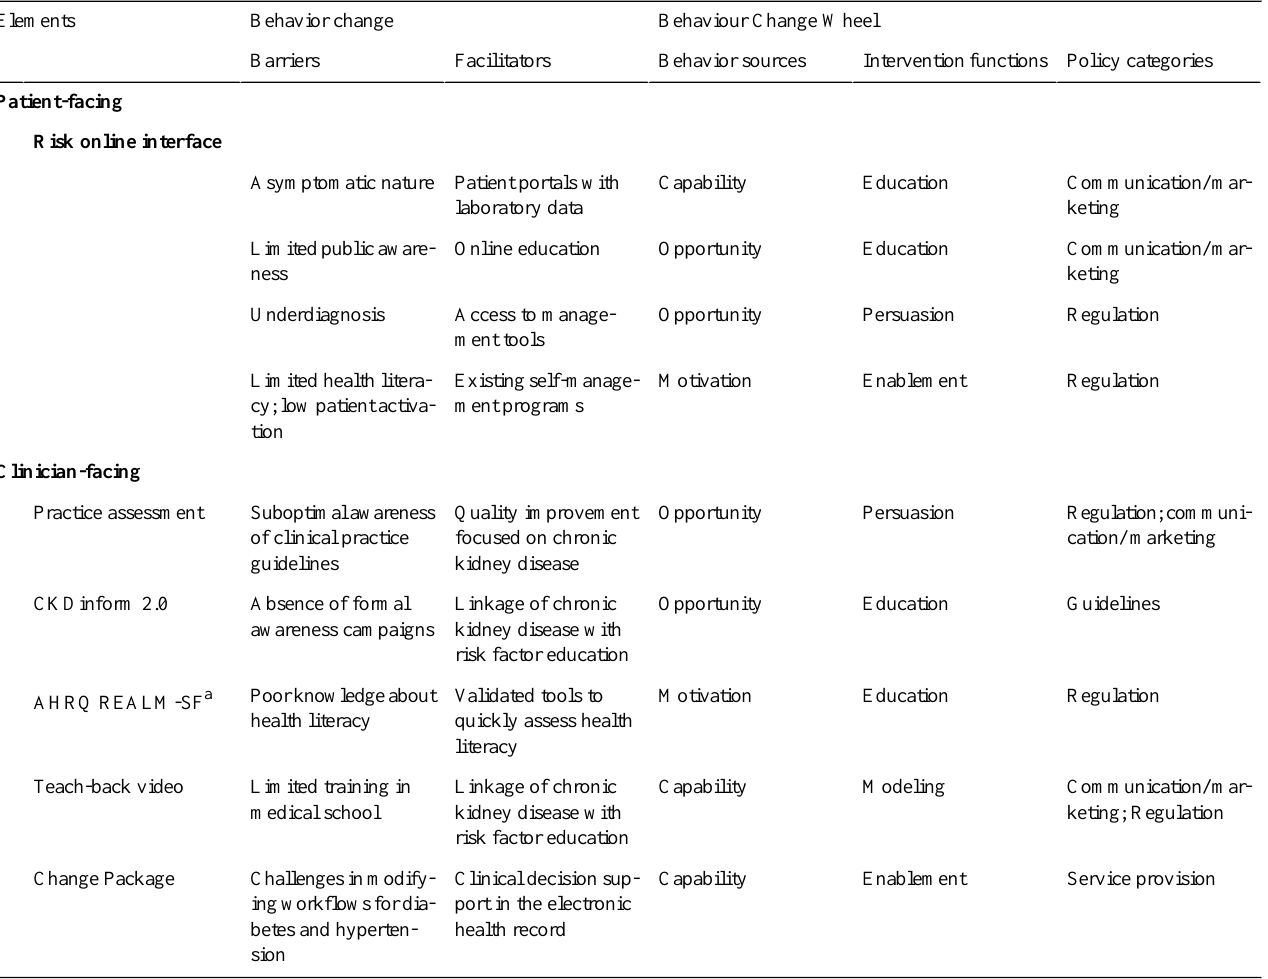
Table 1. Elements of the Kidney Score Platform informed by the 3 layers of the Behavior Change Wheel framework to directly address patient and clinician barriers and facilitators of behavior change for chronic kidney disease awareness, communication, and